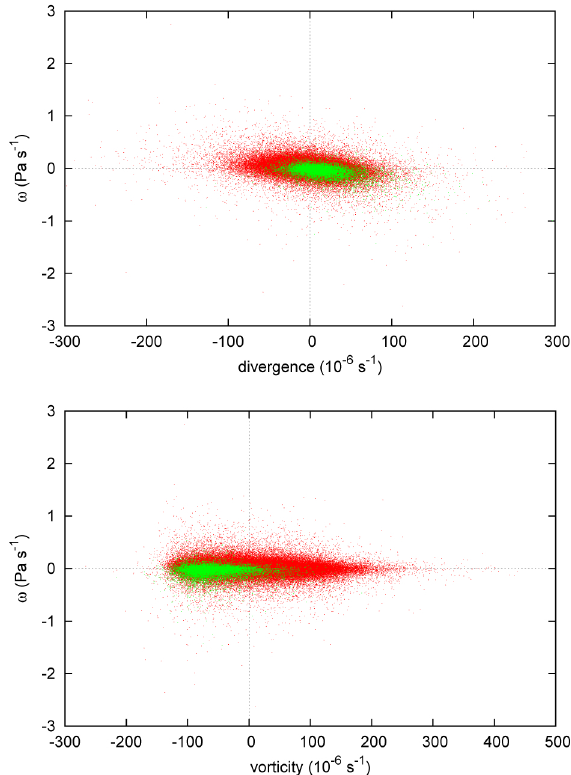
Fig. 4. Scatter plot of vertical velocity, ω = d p/ d t , and divergence (top panel) or vorticity (bottom panel) for a reduced sample of the Europe data. Red dots refer to all humidity values, green dots to ice superaturated areas